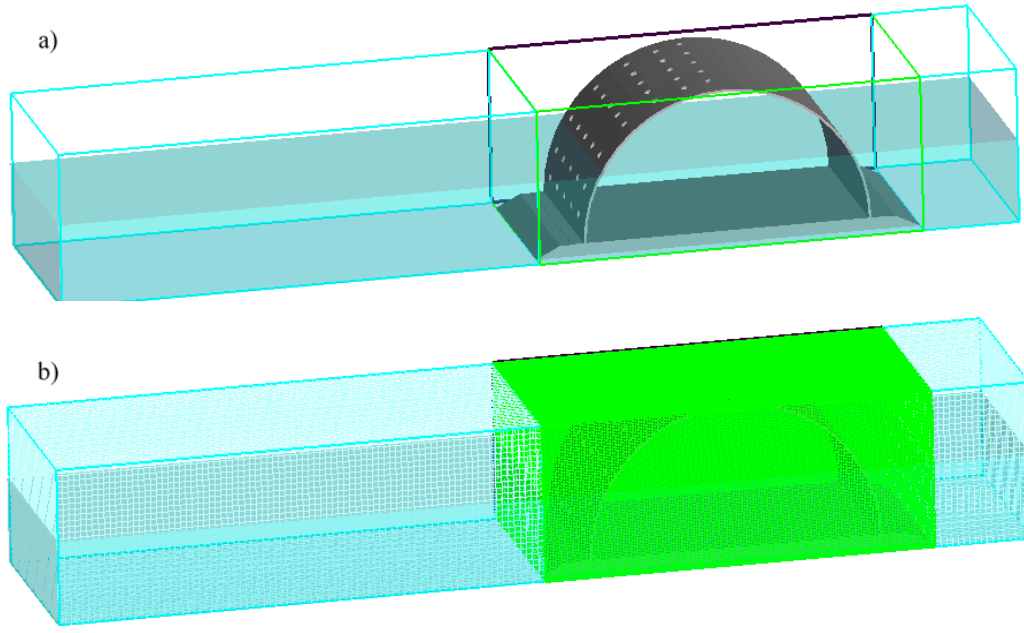
Figure 2. ( a ) Numerical model geometry; and ( b ) grid used to discretize the model domain.